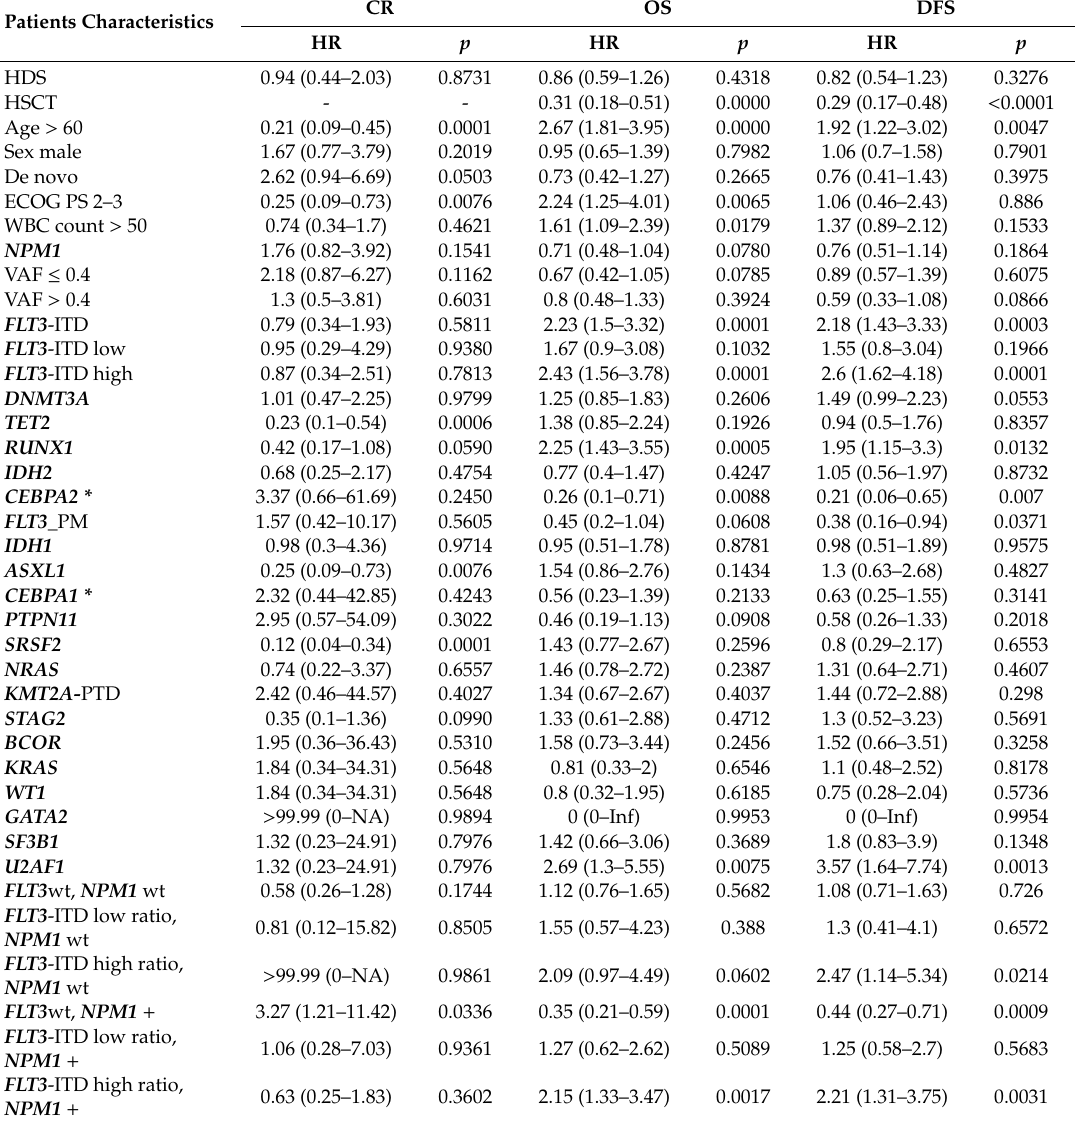
Table 2. Univariate analysis on patients